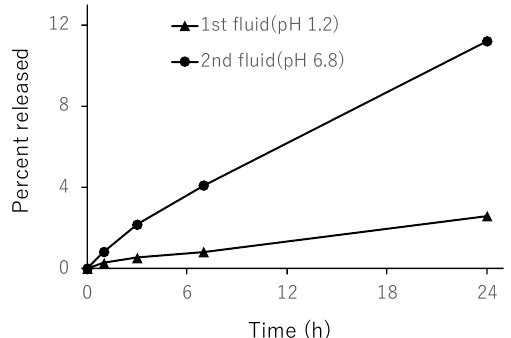
Figure 5. Release of prednisolone (PD) from nanogel (NG(S)) in the JP-17 1st and 2nd fluids at 37 °C. The results are expressed as the mean ± S.D. ( n = 3).